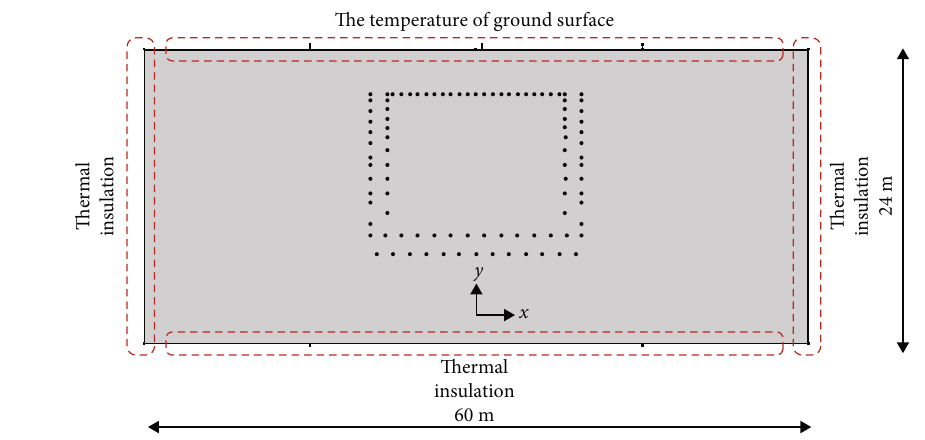
Figure 14: The numerical model and boundary condition. Table 3: Parameters for numerical